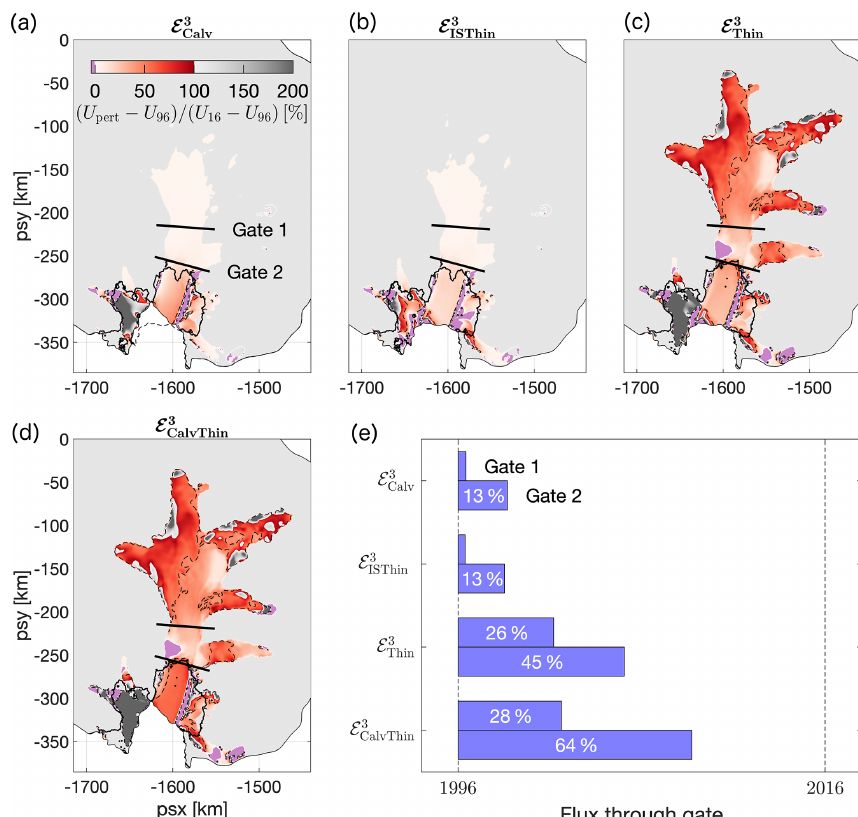
Figure 3. Modelled changes in surface speed compared to 1996 for prescribed perturbations of the Pine Island Glacier geometry. (a) Retreat of the calving front. (b) Thinning of the ice shelf. (c) Thinning of the ice shelf and grounded ice, including grounding line retreat. (d) Calving and thinning combined. For each perturbation, the modelled change in speed ( U pert − U 96 ) is expressed as a percentage of the observed speed- up between 1996 and 2016 ( U 16 − U 96 ). Dashed black lines correspond to the 50% contour. Panel (e) shows the percentage of the observed flux changes through Gate 1 and 2 that can be explained by the respective perturbations. The simulated impact of calving and thinning in experiment E 3 only represents 28 and 64% of the measured flux changes respectively. Possible explanations for the unaccounted-for CalvThin increase in flow speed are provided in Sect. 3.2 and 3.3